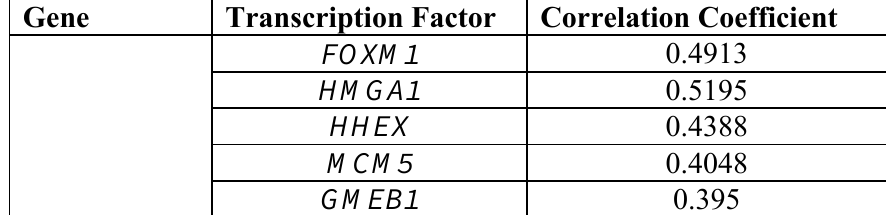
Table 5: The list of transcription factors correlated to breast cancer